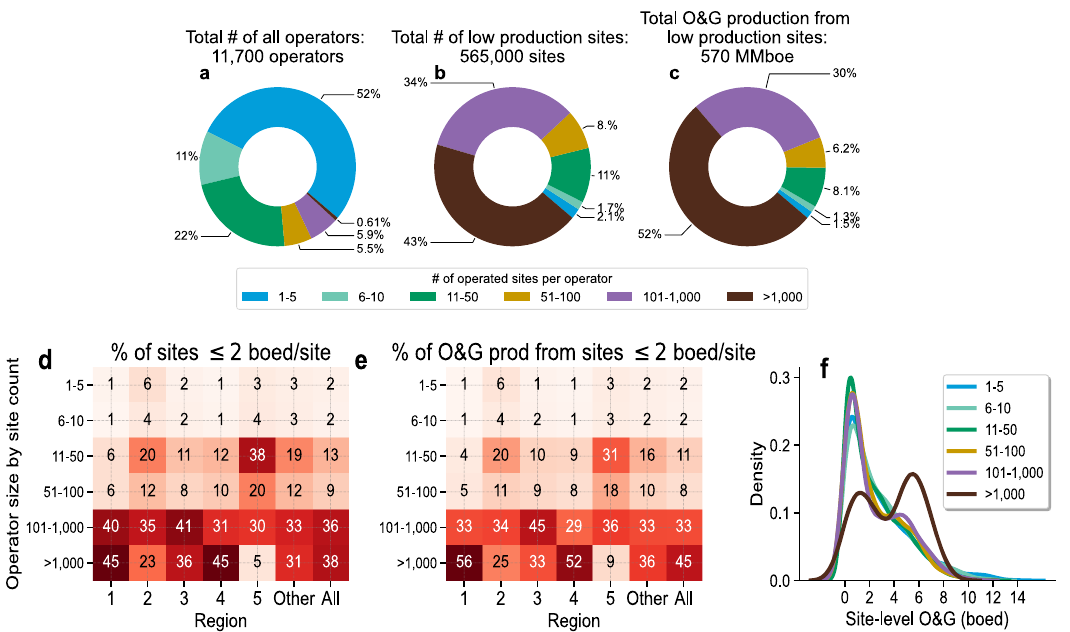
Fig. 2 Low production well site operator pro fi le. a Distribution of the total number of all O&G well site operators. b Distribution of the number of operated low production well sites by operator size. c Distribution of O&G production for operators with 1 – 5 (blue), 6 – 10 (light green), 11 – 50 (dark green), 51 – 100 (orange), 101 – 1,000 (purple), and >1,000 operated sites (dark red). d Heatmap showing the distribution of well sites and e the distribution of O&G production for only the ultralow production sites (producing ≤ 2 boed/site) and for each operator category within each region shown in Fig. 1. “ Other ” means all locations not included in Regions 1 – 5 in Fig. 1 and “ All ” indicates national statistics for all ultralow production sites. For example, in Region 1, 1% of ultralow production well sites are owned by operators with 1 – 5 sites each and, for these sites and operators, their combined production accounts for only 1% of the total. f Density plot showing similarities in the distribution of mean site-level O&G production for each operator category. For operators with more than 50 operated well sites, a bimodal distribution or the second cluster of sites producing >2 boed/site emerges. Operator names and data are based on Enverus Prism ’ s 19 aggregation into single operator names, including rolling up subsidiaries to the parent company whenever such information is publicly